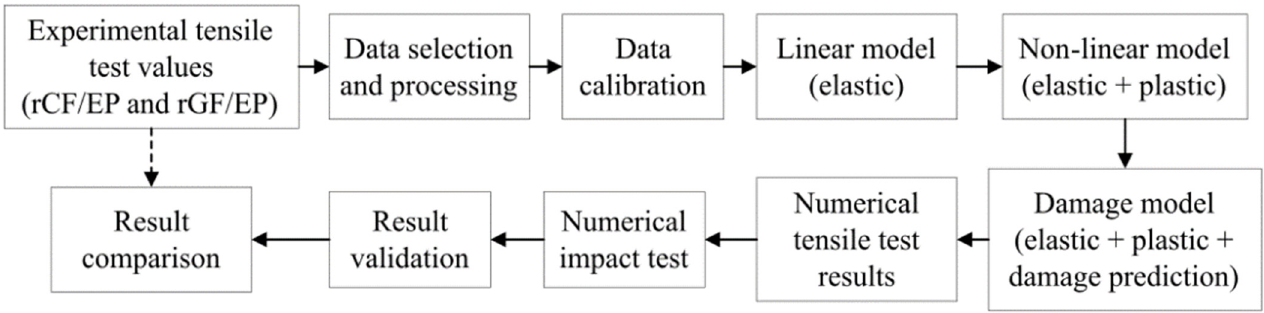
Figure 4. Implemented FE approach for the recycled composites.